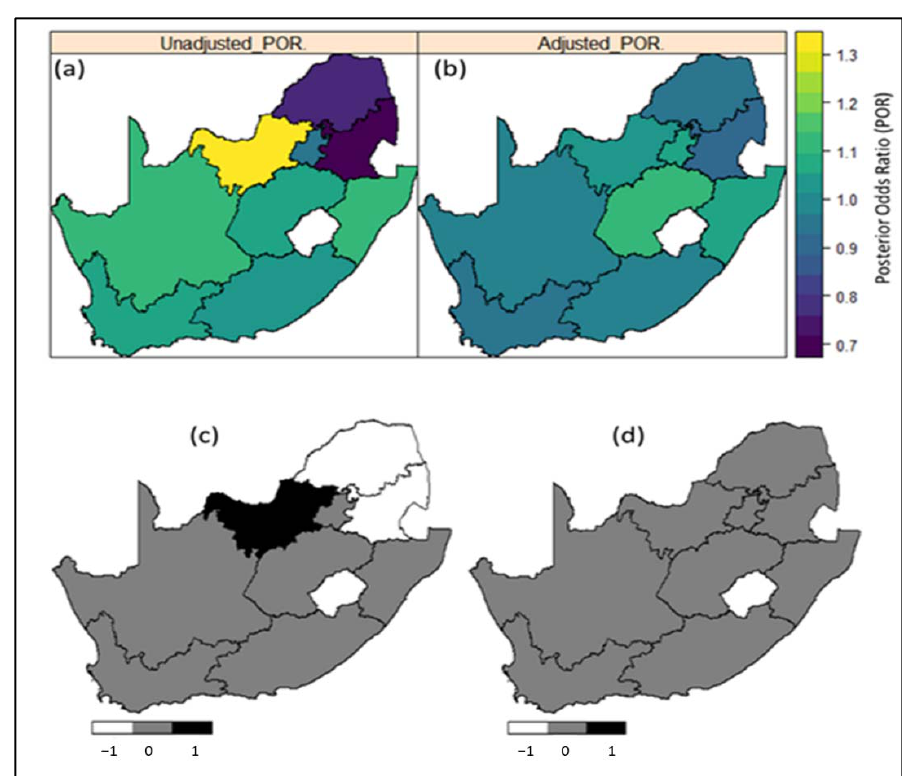
Figure 4. Estimates of mean posterior odds ratio (POR) of the spatial effects on prevalence of hypertension across the nine (9) provinces in South Africa based on ( a ) unadjusted model and ( b ) adjusted model; the corresponding significance maps of the posterior estimates based on 95% credible interval for ( c ) unadjusted model and ( d ) adjusted model. Evidence based on the 2012 SANHANES dataset. Blue to red correspond to low risk to high-risk provinces. Note that in Figure 3, the central white patch (Lesotho) is excluded from the map. In Figure 3a,b, dark blue to yellow correspond to low risk to high risk provinces. In Figure 3c,d, black colour corresponds to significantly high risk regions; white colour corresponds to significantly low risk regions; and grey colour correspond to regions where the risks are not statistically significant.